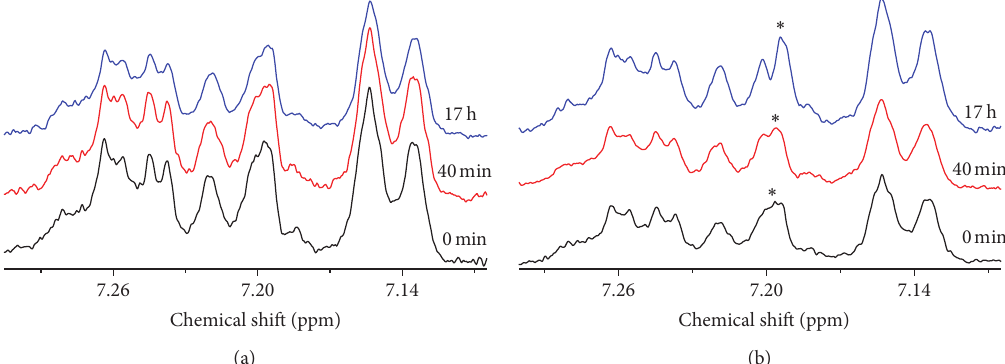
Figure 6: The interaction between hIAPP and Al(III). (a) and (b) are 1 H NMR spectra of 100 𝜇 M hIAPP without and with 100 𝜇 M Al(III), respectively, after 0min (black), 40min (red), and 17h (blue) incubation. The asterisks show the 𝐻 𝜀 resonance of